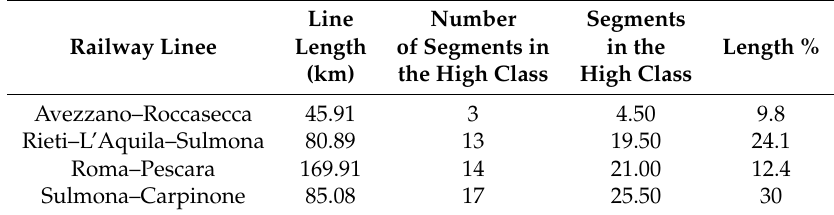
Table 15. Number and total length of the most exposed segments.